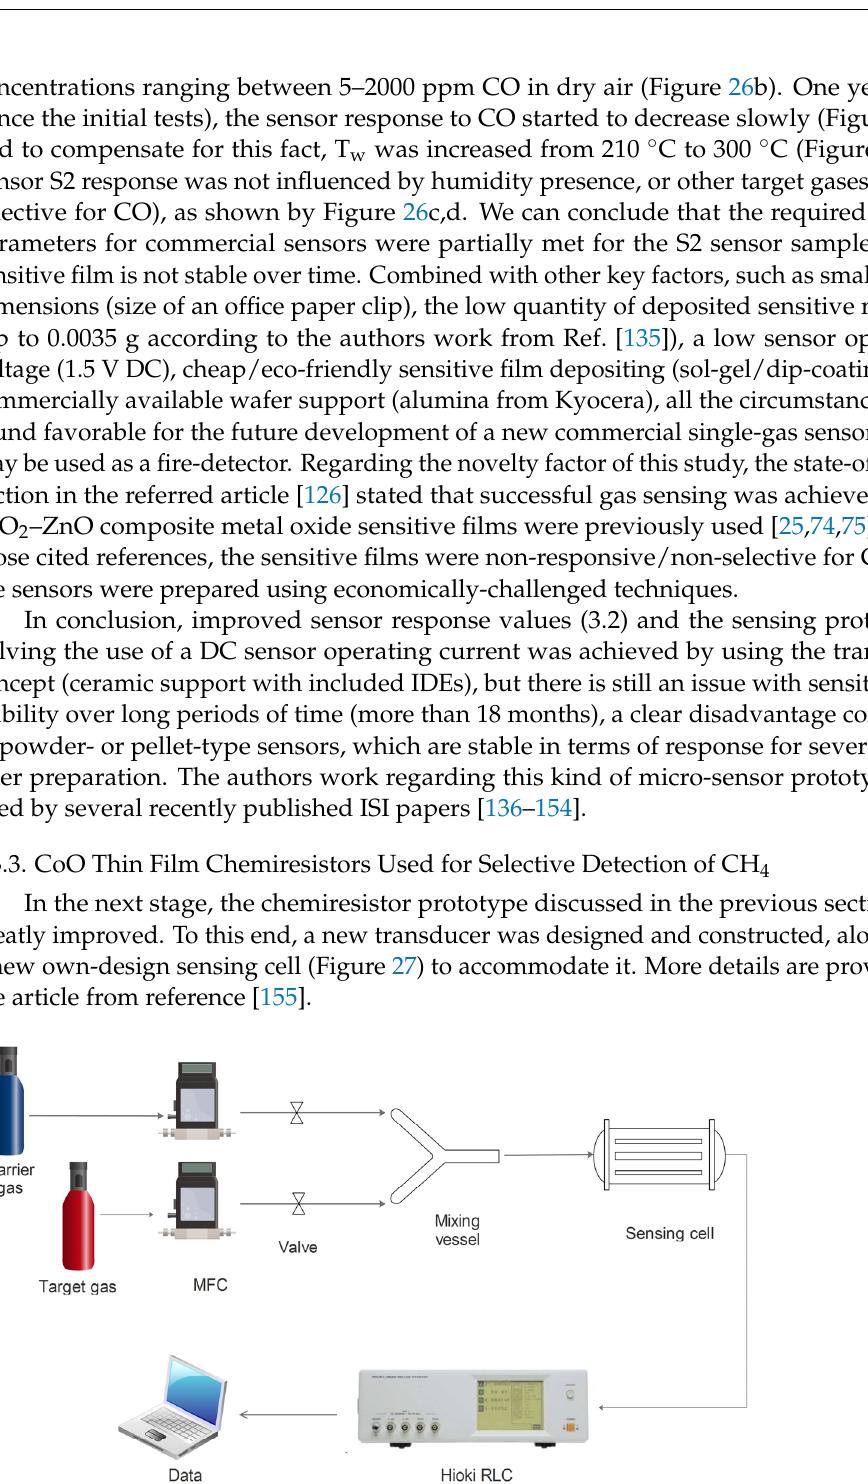
Figure 28. The new alumina transducer prototype measured at 5 × 10 × 0.6 mm: ( a ) platinum or gold IDE and platinum heater circuit-schematic representations; ( b ) actual sensor sample com- pared with various objects for sizing purposes, from ref. [155]. On these newly-designed alumina transducers, thin films of CuO and CoO were deposited via a sol-gel/spin coating method, which is considered eco-friendly and also cheap. The precursors were Cu(CO 3 ) 2 Cu(OH) 2 for CuO and Co(CO 3 )Co(OH) 2 for CoO,